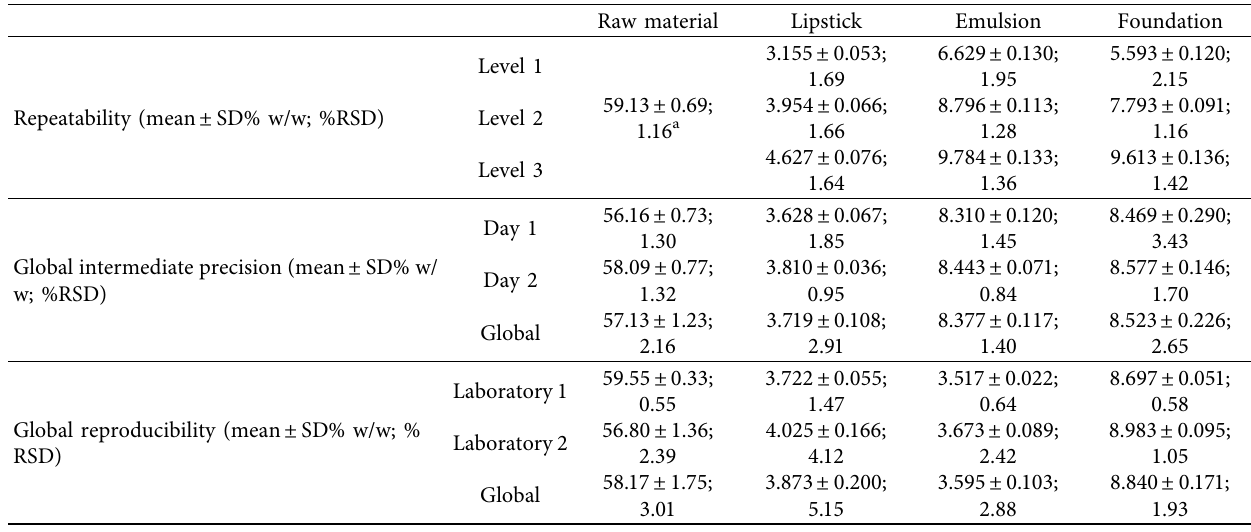
Table 4: Average found concentration, standard deviation, and total variation (%RSD) for the precision levels considered in this